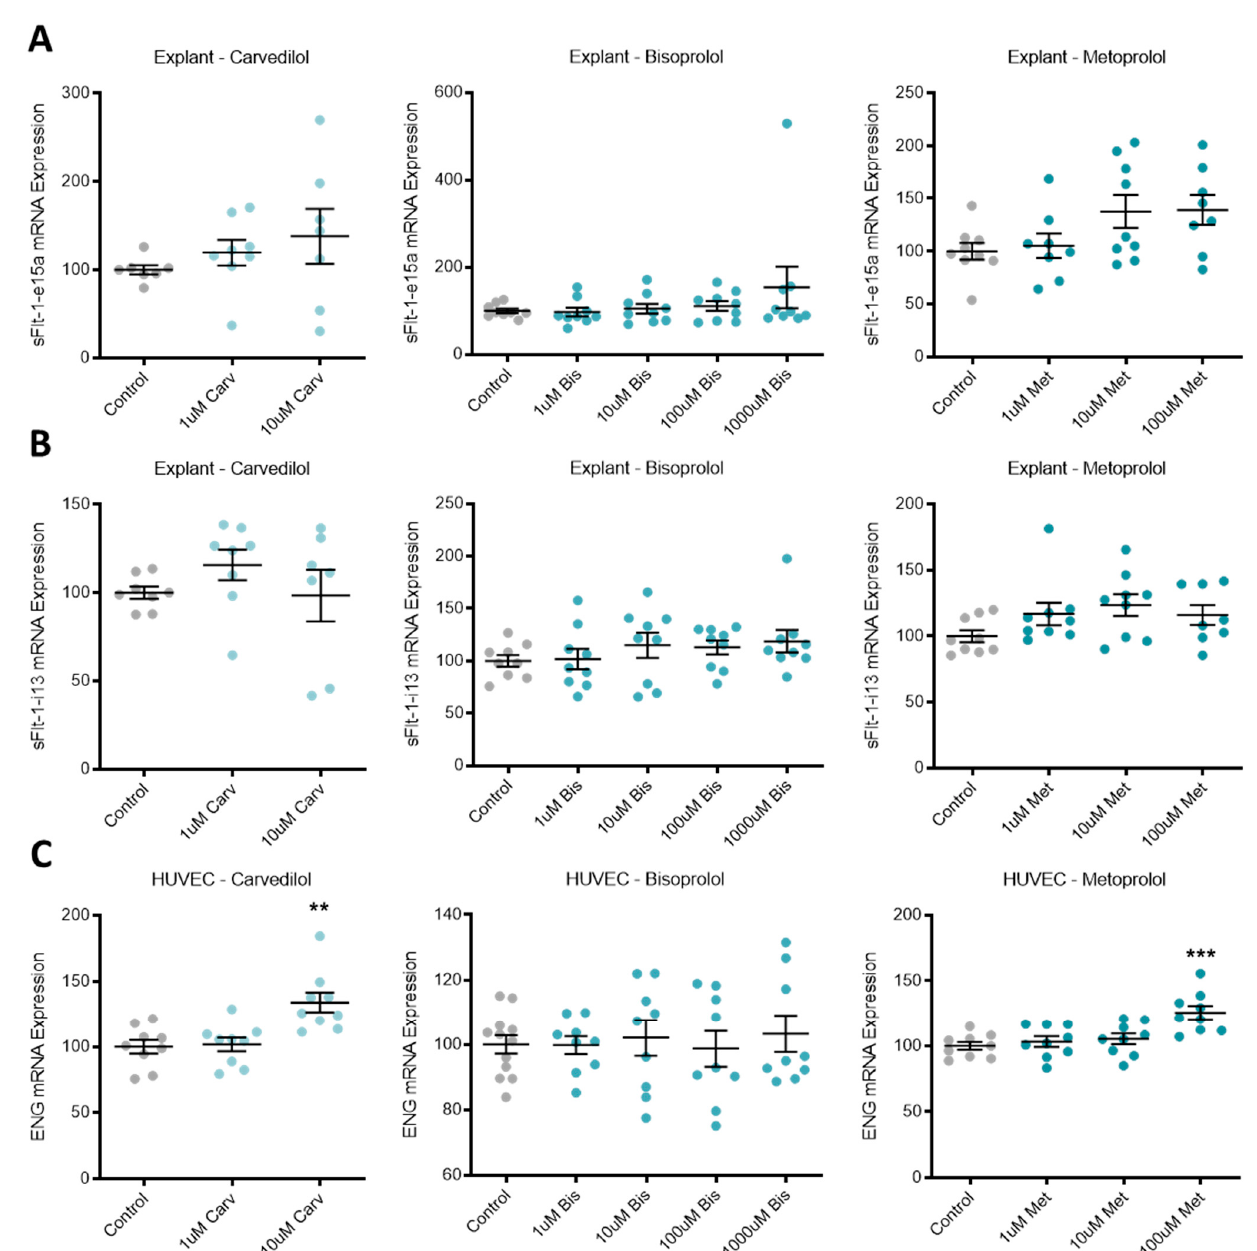
Figure 2. Endoglin mRNA is upregulated in HUVECs following beta-blocker treatment. Placental explant expression of sFlt-1 isoforms, sFlt-1-e15a ( A ) and sFlt-1-i13 ( B ) was not affected by treatment with beta-blockers carvedilol (Carv), bisoprolol (Bis), or metoprolol (Met). HUVEC expression of ENG mRNA ( C ) was significantly increased with top dose Carv and Met, but not Bis. Data are mean ± SEM, expressed as a percentage of control, n = 3–4, ** p < 0.01, *** p < 0.001.